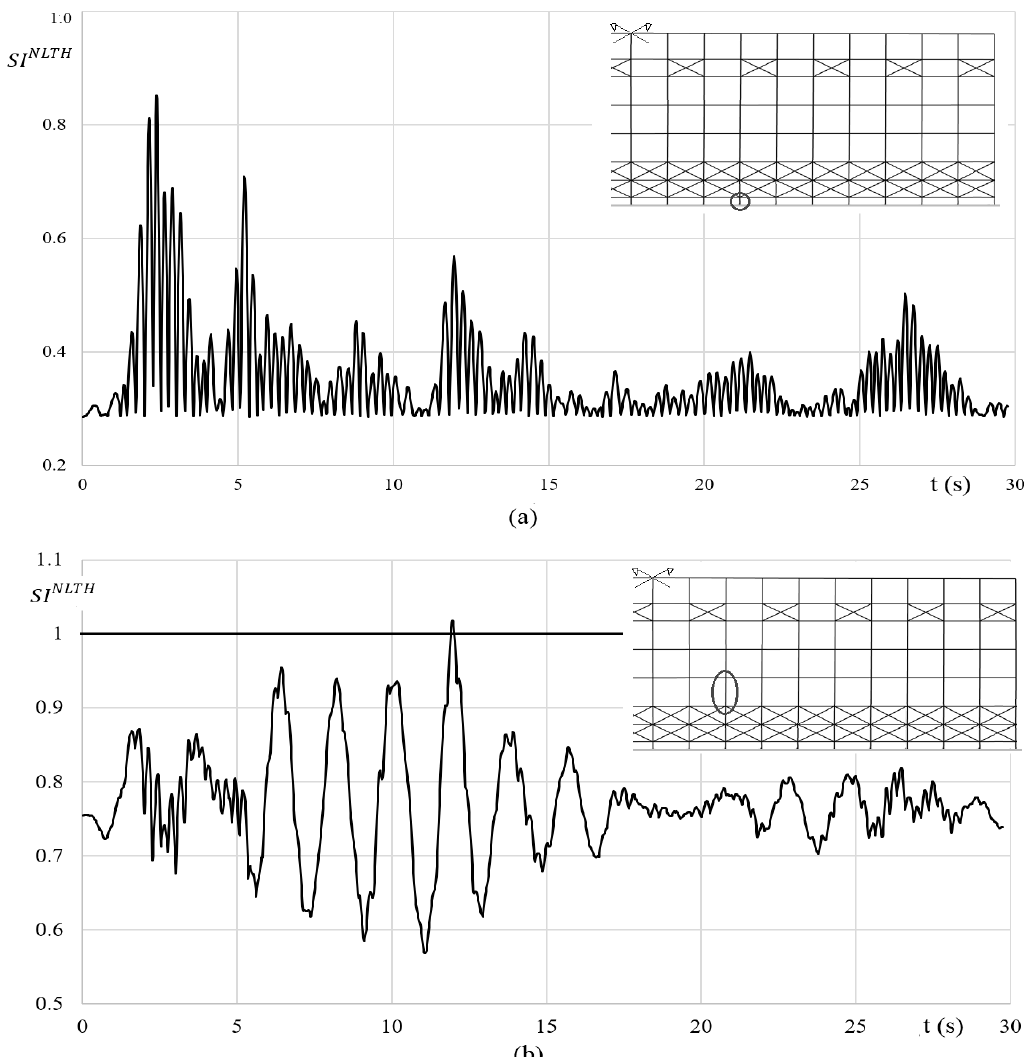
Figure 12. Safety index vs. time (t, in seconds) for Zone_1 with α g = 1.0 in two different positions ( a ) and ( b ).